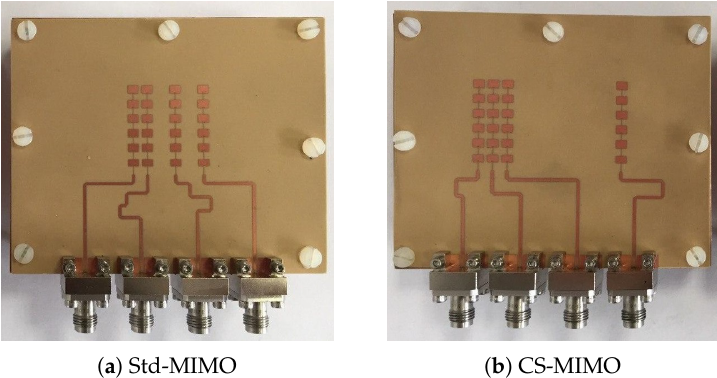
Figure 4. Photograph of 2 × 2 MIMO antenna prototype